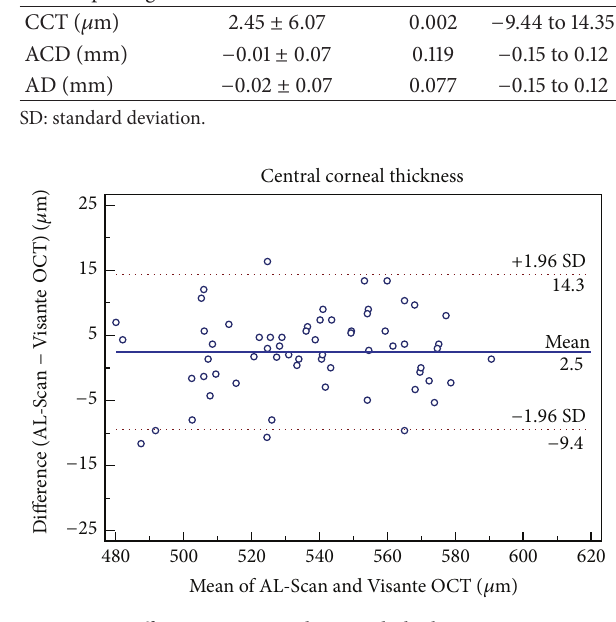
Figure 1: Difference in central corneal thickness measurements between AL-Scan optical biometer and Pentacam rotating Scheimp- flug imaging device against their mean values. The solid line indi- cates the mean difference, and 95% limits of agreement are indicated by solid and dotted lines,